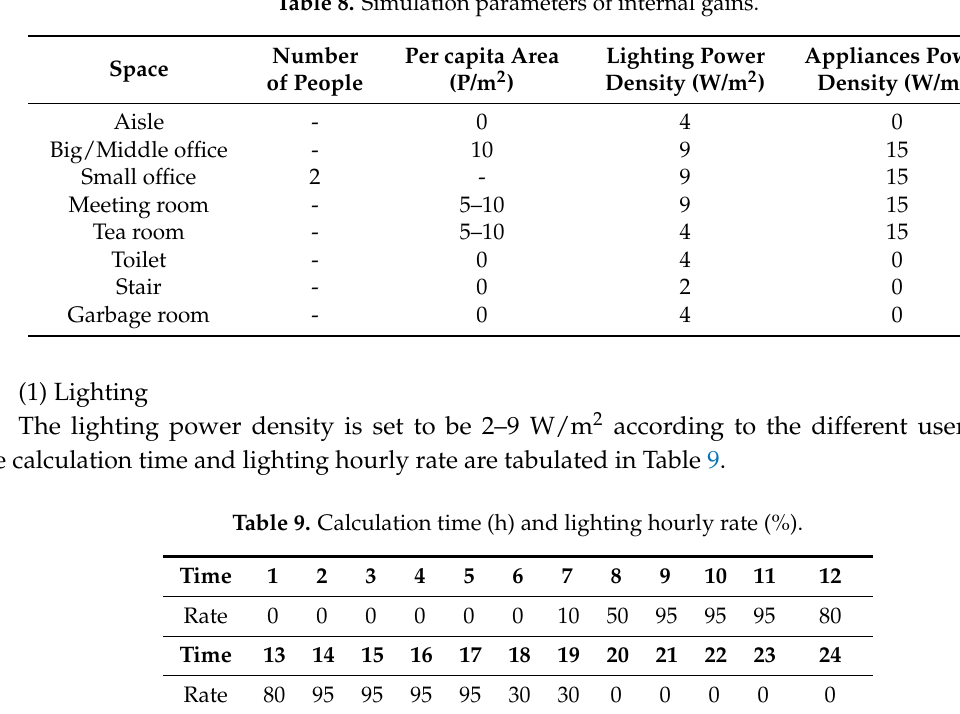
Table 8. Simulation parameters of internal gains.